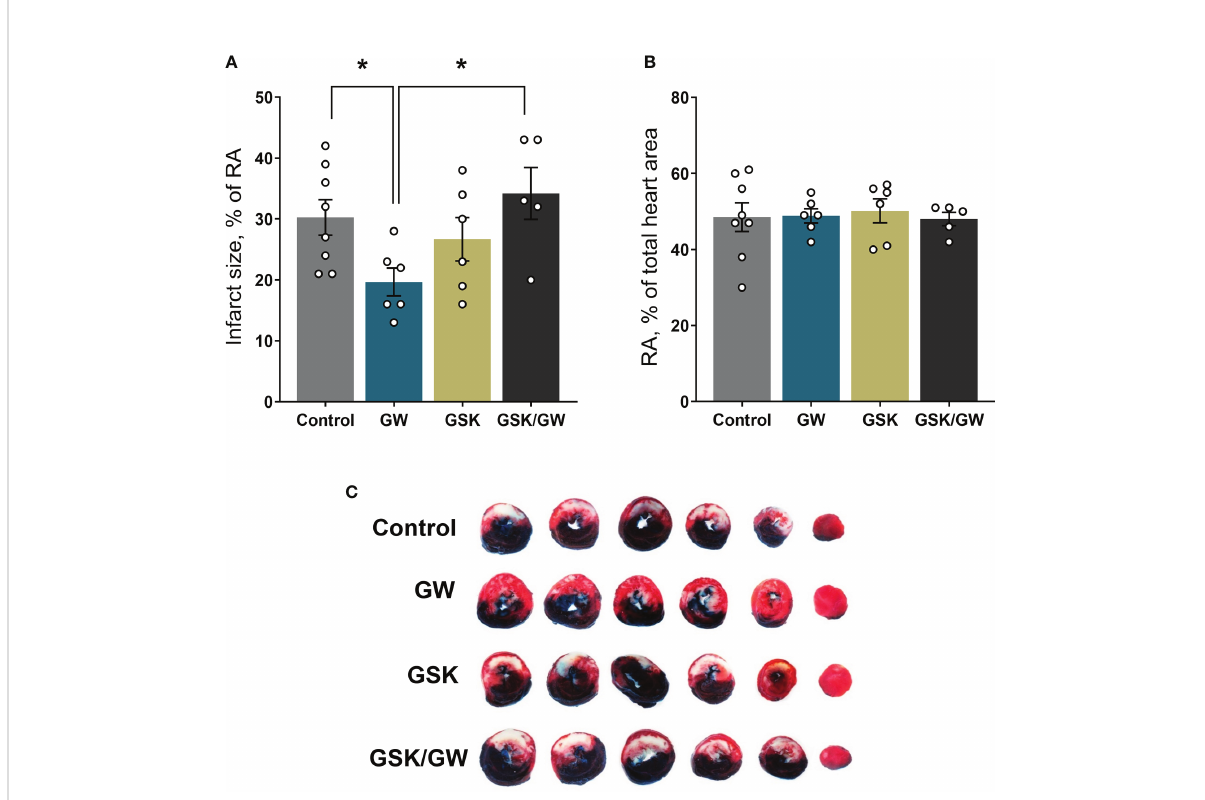
FIGURE 5 Activation of PPAR b / d leads to reduced infarct size after ex vivo I/R. (A) NA (necrotic area) size as % percentage of the RA (risk area) size after ex vivo LAD-occlusion and reperfusion ( ex vivo I/R) (B) % of the RA size compared with total cardiac tissue area. (C) Representative images of the stained cardiac slices for each experimental group. Infarct size was determined with TTC staining and measured using imaging software. Results are presented as means ± SEM from 5-8 independent experiments. RA, risk area; NA, necrotic area; LAD, left anterior descending coronary artery; GW, pretreated with PPAR b / d agonist GW0742; GSK/GW, pretreated with PPAR b / d antagonist GSK0660 and then pretreated with PPAR b / d agonist GW0742. *p <